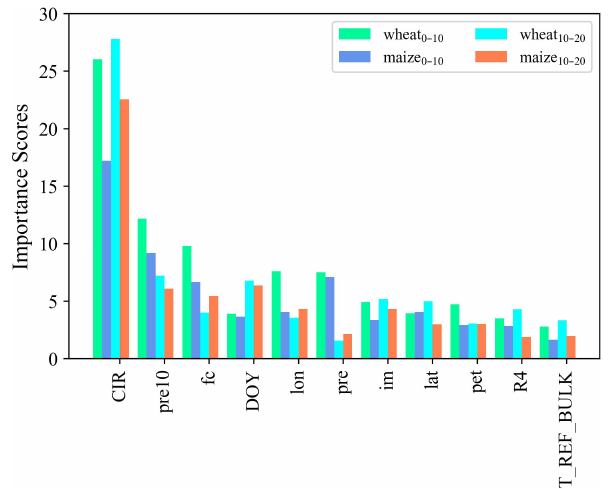
Figure 5. The importance scores of 11 independent variables and the irrigation factor